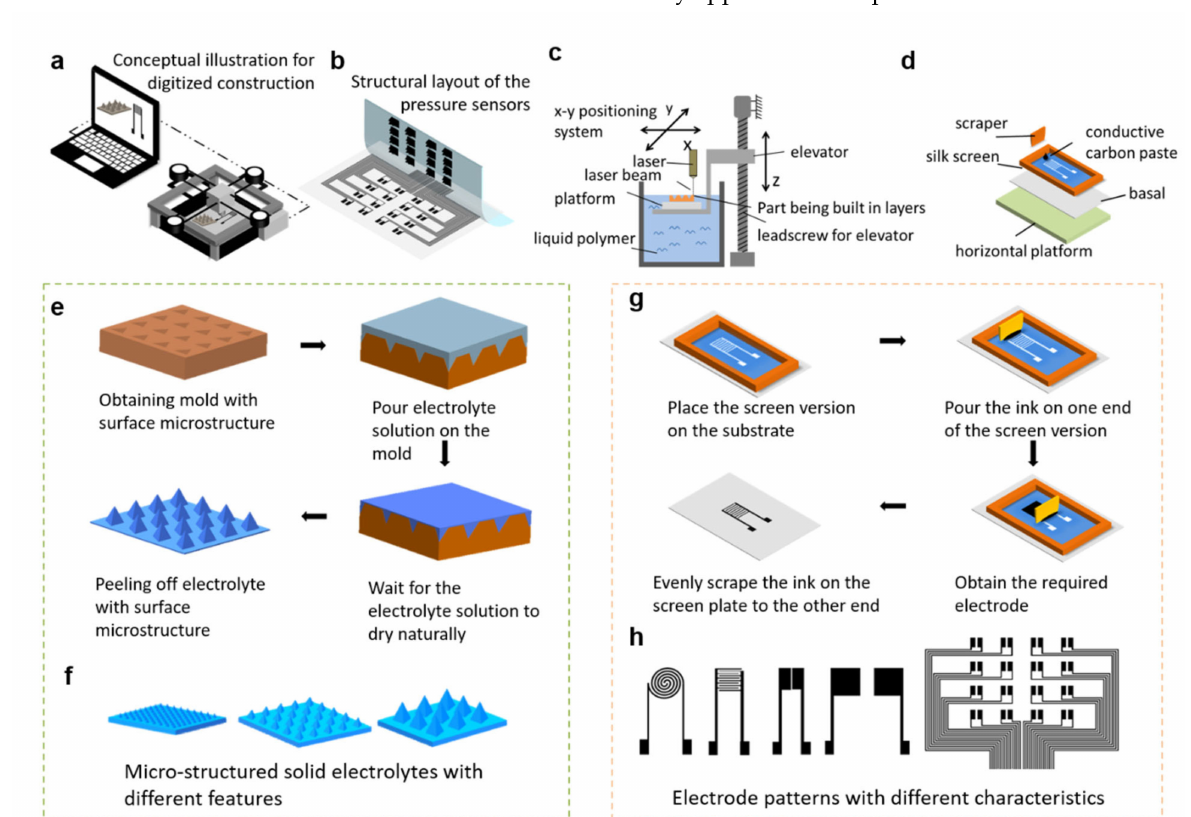
Figure 1. Design concept for the digitized fabrication of iontronic pressure sensors. ( a ) Conceptual schematic illustrating the digital manufacturing of iontronic pressure sensors based on 2D and 3D printing. ( b ) The device configuration of the pressure sensors. ( c ) Schematic showing the fabrication of the templates used to construct the micro-structured solid electrolyte based on SLA 3D printing. ( d ) Schematics depicting the basic configurations for the screen printing of electrode patterns. ( e ) Preparation process of the micro-structured solid electrolytes via a solution casting method. ( f ) Illustrations showing that micro-structured solid electrolytes with different shapes and sizes can be obtained using the digitized fabrication method. ( g ) Schematics depicting the screen printing process of the electrode patterns. ( h ) Schematic electrode patterns of different geometric characteristics can be prepared by the screen printing